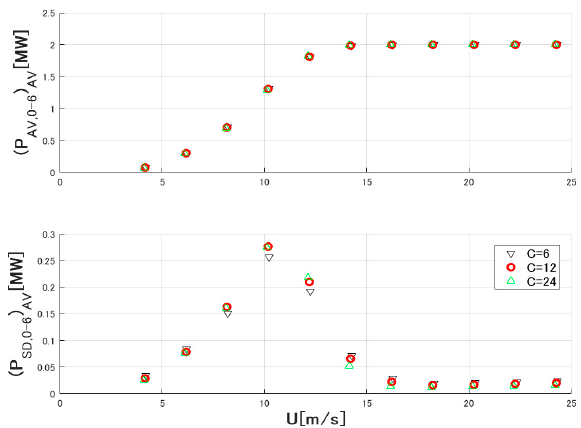
Figure 11. Mean and standard deviation of the output power to the average centre hub wind speed.